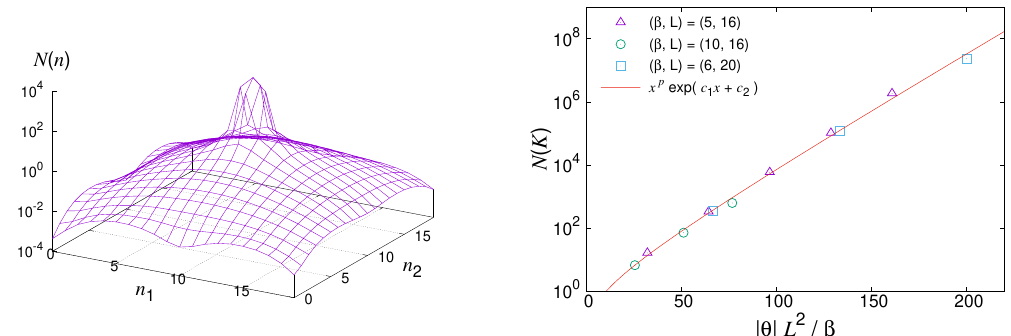
Figure 10 . (Left) The local unitarity norm ( n ) for each plaquette P n de(cid:12)ned by (5.6) is plotted N against n = ( n 1 ; n 2 ) for the punctured model with the log de(cid:12)nition (2.11) of the topological charge for ( (cid:12); L ) = (12 ; 20) with (cid:18) = (cid:25) . The removed plaquette corresponds to n = K = (10 ; 10) in this (cid:12)gure. (Right) The local unitarity norm ( K ) for the removed plaquette P K obtained for various N (cid:12) , L and (cid:18) is plotted against x = (cid:18) L 2 =(cid:12) . The solid line represents a (cid:12)t to x p exp( c 1 x + c 2 ) with j j